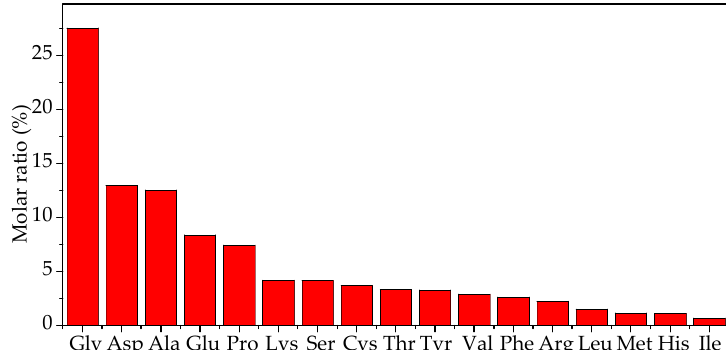
Figure 10. Amino acids in EPS secreted by B. subtilis J2 in the liquid culture medium.